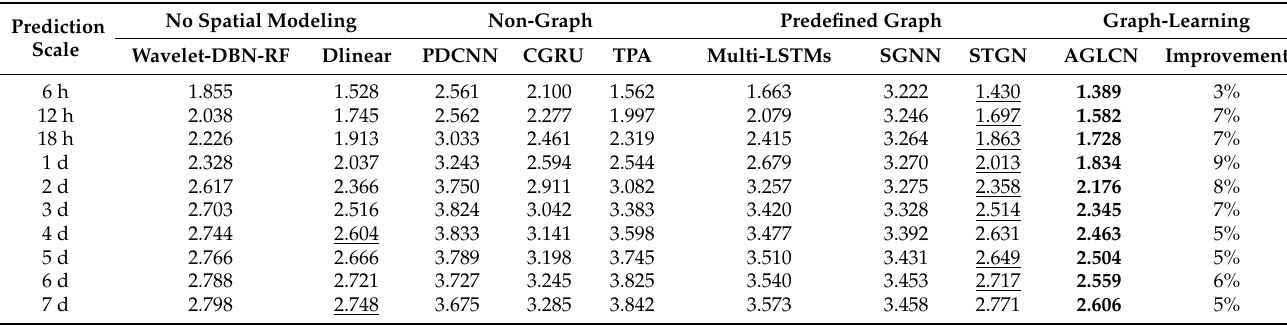
Table 4. RMSE of forecasting methods for 120